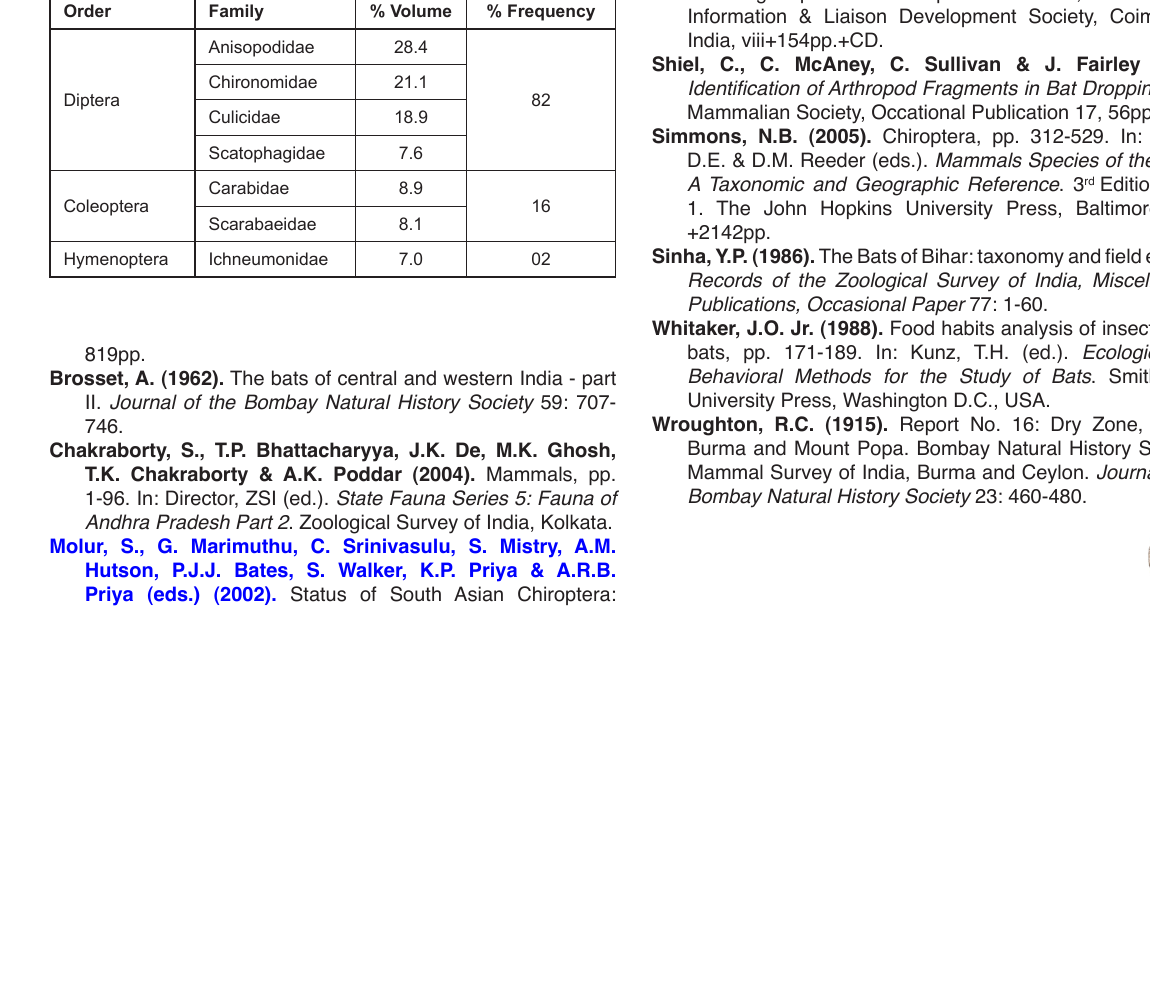
Table 2. Dietary composition of Scotophilus kuhlii from Secunderabad